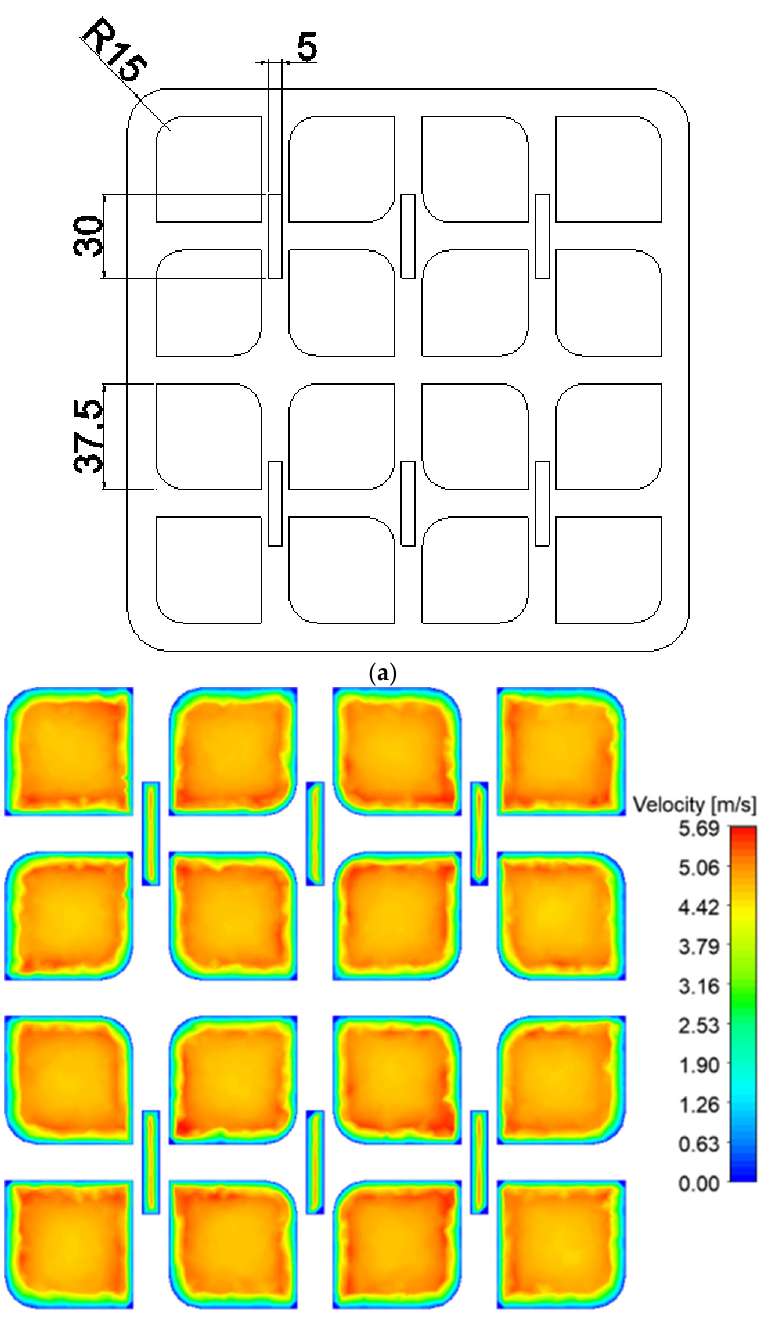
Figure 6. ( a ) The geometry of the turbulence ‐ generating grid, where the given dimensions are in mm and the overall dimensions are (200, 200) mm. ( b ) The time ‐ averaged velocity magnitude field at the grid.